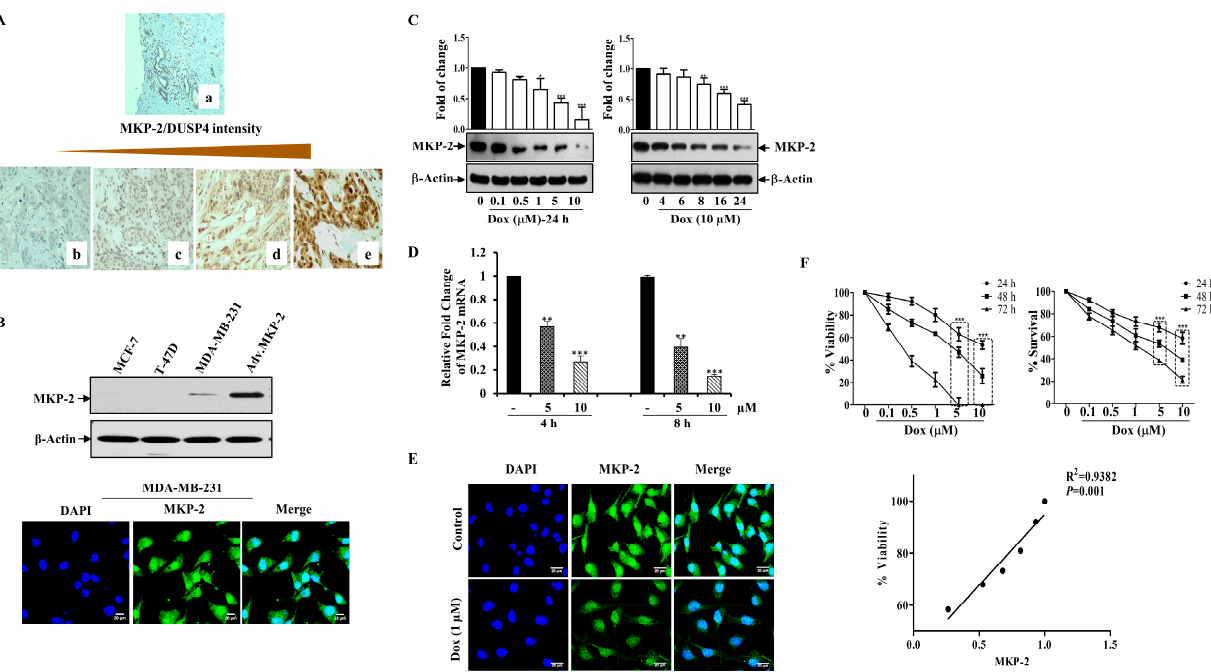
Figure 1. Dox Inhibits MKP-2 Expression and Reduces Cell Viability. ( A ) MKP-2 protein expression in breast carcinoma cases. ( a ) Normal breast tissue with negative MKP-2 expression, ×100. ( b ) Invasive ductal carcinoma with negative MKP-2 expression, ×200. ( c ) Invasive ductal carcinoma with mild MKP-2 expression, ×200. ( d ) Invasive ductal carcinoma with moderate MKP-2 expression, ×200. ( e ) Invasive ductal carcinoma with high MKP-2 expression, ×400. ( B ) MCF-7, T-47D, and MDA-MB-231 cell lysates were prepared, separated by SDS-PAGE, and then assessed for MKP-2 and β -Actin expression, and a confocal image of the immunofluorescence staining for MKP-2 in MDA-MB-231 cells was taken. ( C ) MDA-MB-231 cells were treated with increasing concentrations of Dox (0.1–10 µM) for 24 h or with 10 µM up to 24 h, then assessed for MKP-2 and β -Actin. ( D ) MDA-MB-231 cells were treated with Dox (5 or 10 µM) for 4 or 8 h, and then the expression of MKP-2 mRNA was analyzed by quantitative real-time PCR. ( E ) Immunofluorescent images of MKP-2 expression in control and cells treated with Dox (1 µM) for 24 h. ( F ) MDA-MB-231 cells were treated with increasing concentrations of Dox (0.1–10 µM) for 24, 48, or 72 h and then cell viability and % of surviving cells were assessed. A correlation analysis of MKP-2 protein expression and cell viability was calculated. Each value represents the mean ± S.E.M of three independent experiments. * p ≤ 0.05, ** p ≤ 0.01, *** p ≤ 0.001, compared with the untreated control.